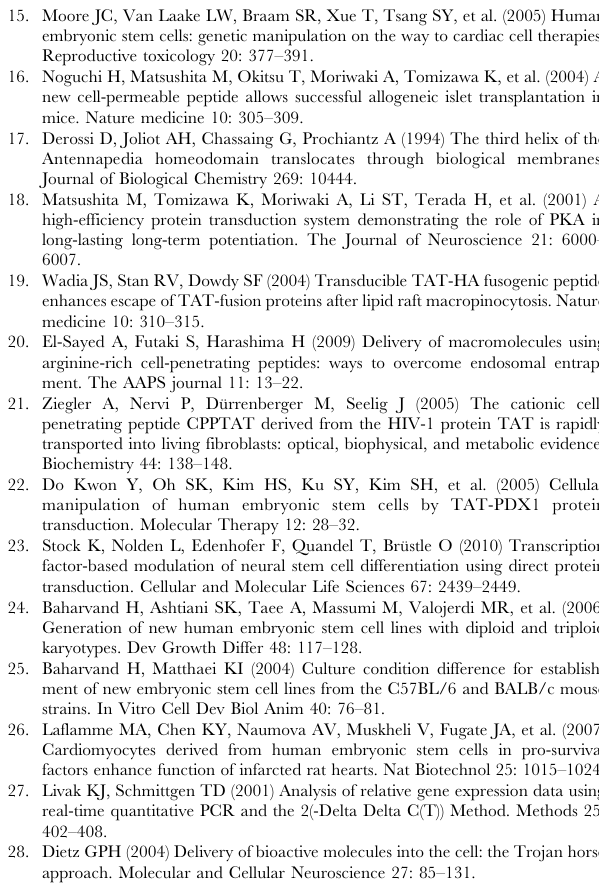
induction. Table S1 Primers and reaction conditions used in real time RT-PCR